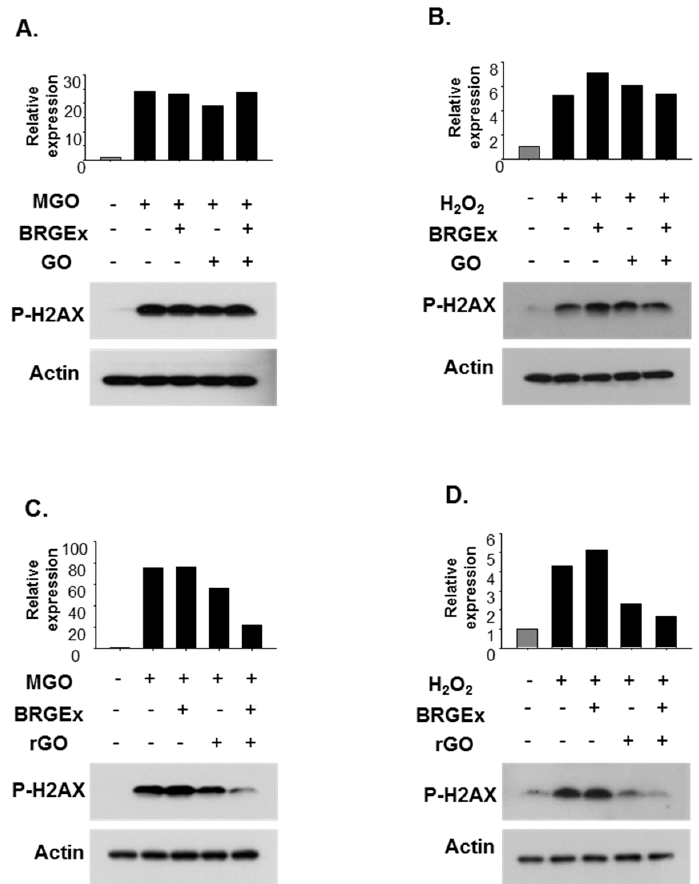
Figure 3. Effect of graphene oxide (GO) and reduced graphene oxide (rGO) with extract of black rice with giant embryo (BRGEx) on phosphorylated H2AX protein levels in B3 cells. B3 cells were pretreated with BRGEx (10 μ g/mL) in the presence or absence of GO (10 μ g/mL) ( A , B ) or rGO (10 μ g/mL) (C,D) for 48 h, then 1 mM of MGO ( A , C ) and 100 μ M of H 2 O 2 ( B , D ) was added to the cells for 2 h. Phosphorylated h2AX protein levels were determined using Western blotting, and β -actin was used as loading control.